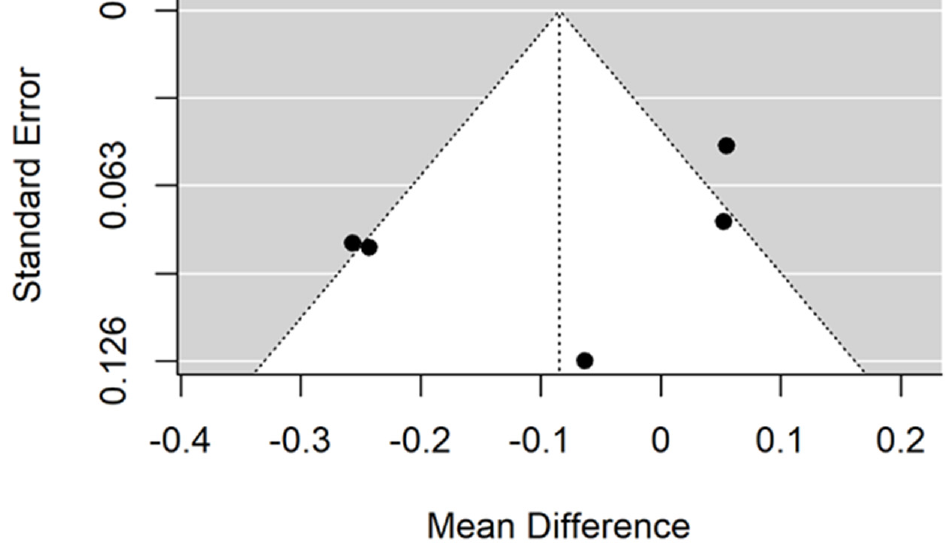
Figure 9. Funnel plot for evalutaion of influence of thread depth dimension on pull-out strentght in animal bone model